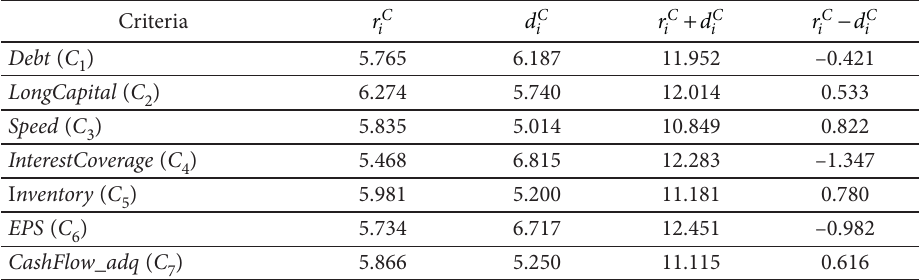
Table 8. Relative influences of criteria